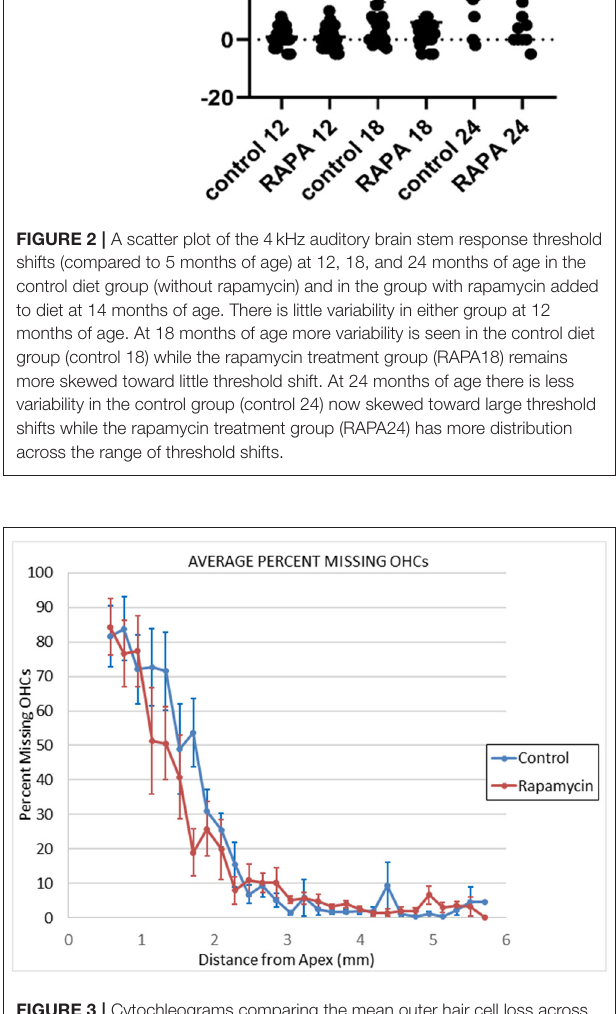
FIGURE 3 | Cytochleograms comparing the mean outer hair cell loss across the cochlea spiral at 24 months of age in mice from the group that had rapamycin added to diet at 14 months of age (red line) vs. the control diet group without rapamycin added to diet (blue line). Apical cochlea is to the left and base to the right, the transition from apical turn to basal turn is ∼ 1.75mm from the apex and the transition from basal turn to the hook is at ∼ 3.9mm from apex. There is large loss of outer hair cells in the apical third of the cochlea in both groups and minimal loss in the remaining cochlea (including hook) in both